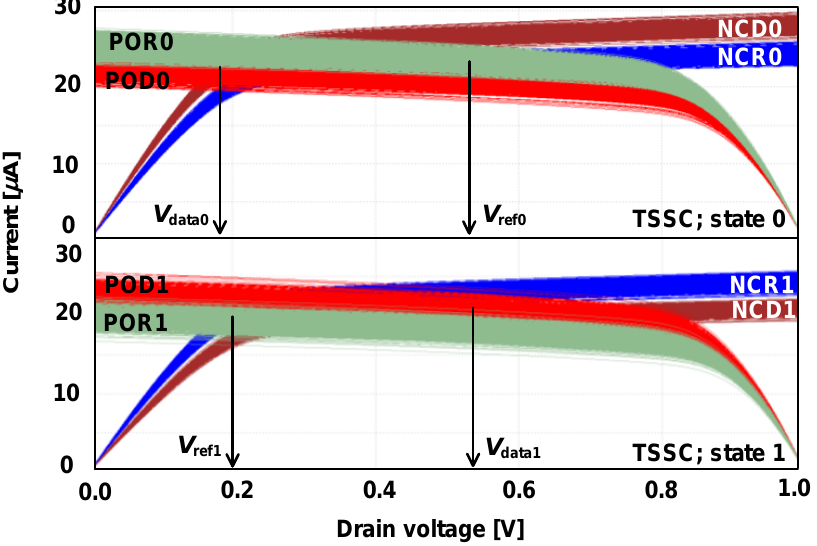
Figure 4. I-V curves of the TSSC with both MOSFET and MTJ process variations for analyzing operating points.